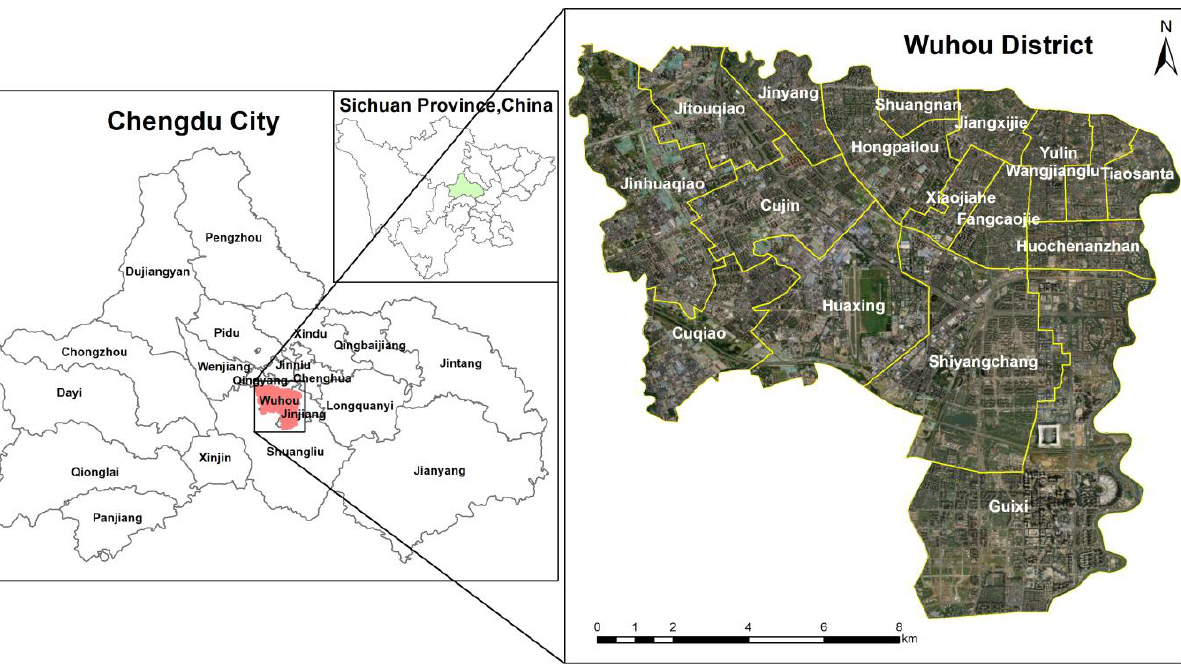
Figure 1. The study Area: the Wuhou District.